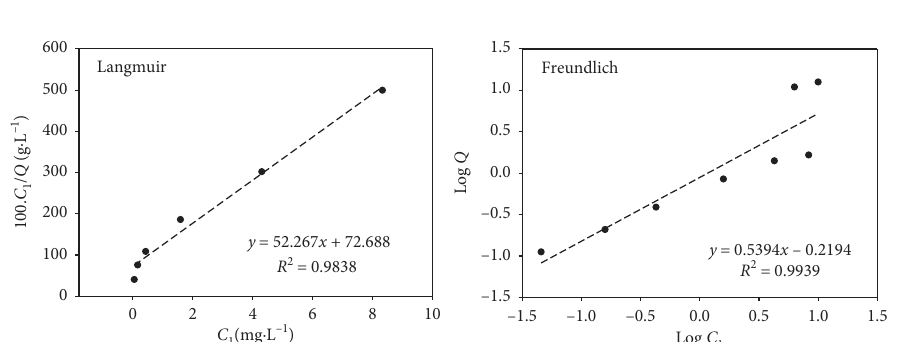
Figure 11: Langmuir and Freundlich adsorption isotherms reflecting Hg 2+ ion adsorption by the FAMBT